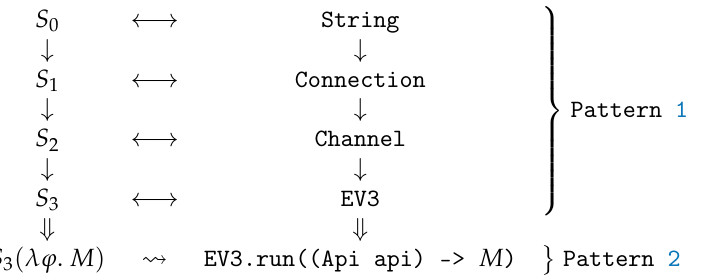
Figure 6. Pipeline of Pattern 1 and Pattern